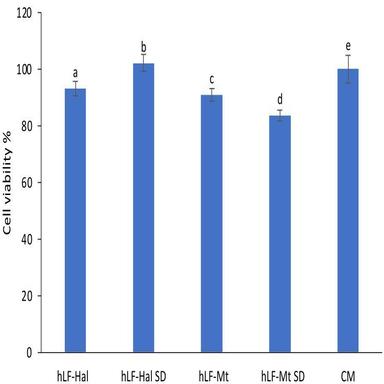
Cell viability % values of cells after 24 h of contact with samples hLF-Hal, hLF-Hal SD, hLF-Mt, hLF-Mt SD (mean values ± s.d.; n = 6). CM was considered as control. ANOVA one-way; post hoc Scheff`e test (p < 0.05): a vs b, d; b vs c, d; c vs d, e; d vs e.